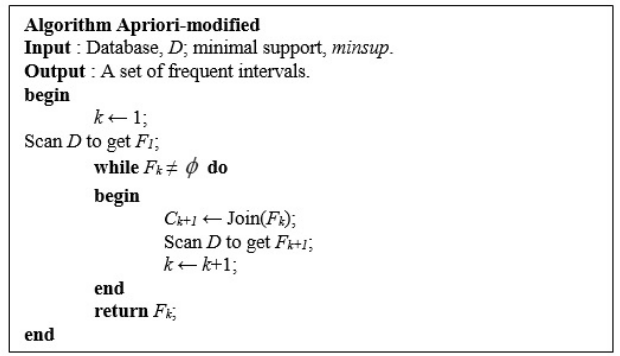
Fig. 3 The Apriori-modified